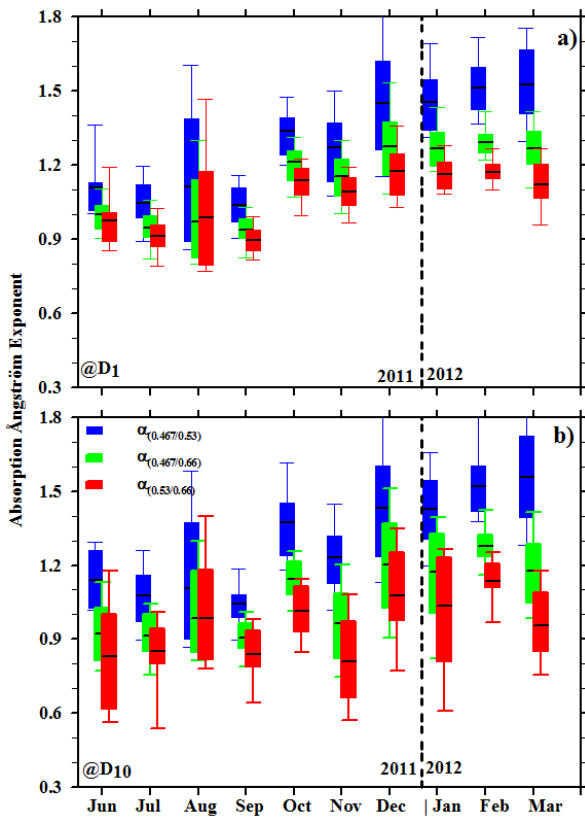
Figure 4. Same as in Fig. 2 but for the absorption Ångström expo-